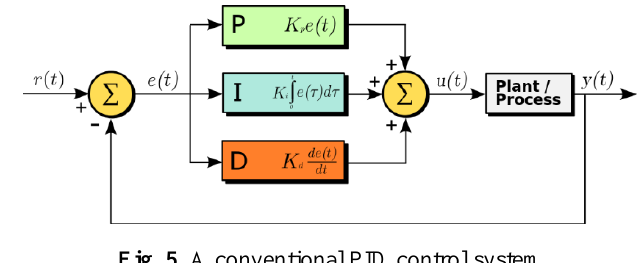
Fig. 5. A conventional PID control system The transfer function of a PID controller is given as Eq. 41.